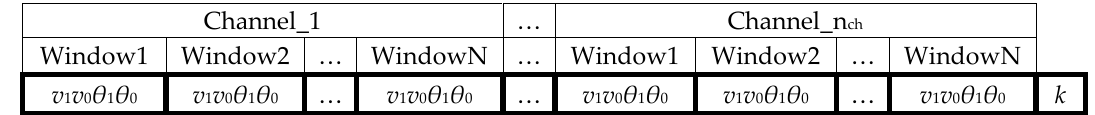
Algorithm 2 Windowed Intervals’ Number kNN (WINkNN) classifier for testing